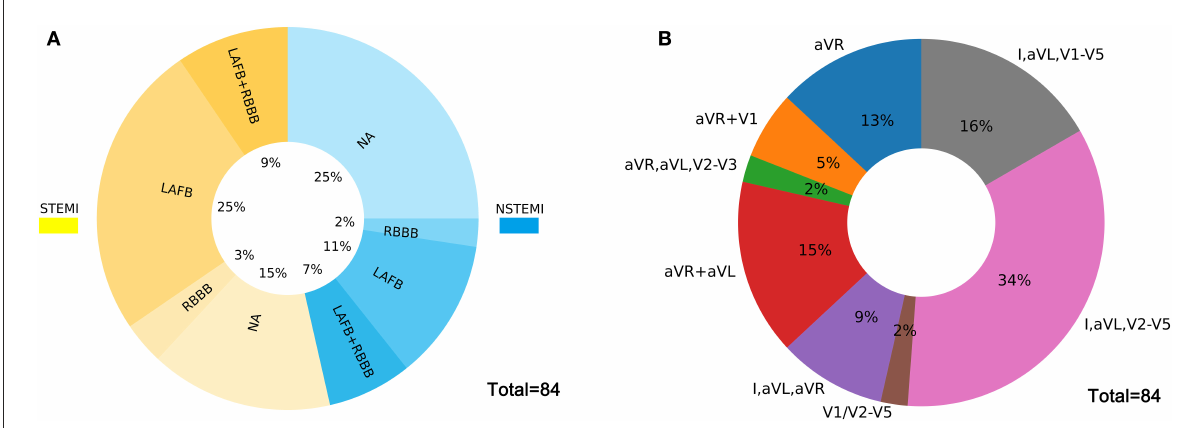
non-ST-segment elevation myocardial infarction; RBBB, right bundle branch block; LAFB, left anterior fascicular block.